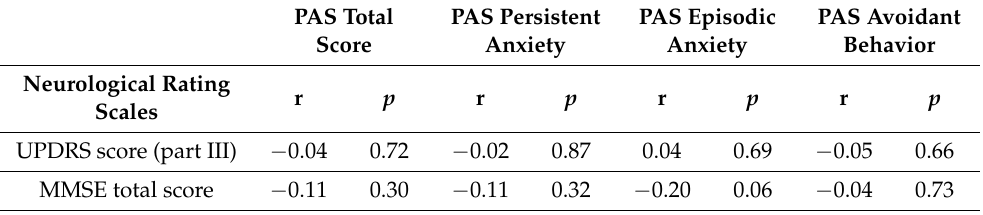
Table 4. Clinical Correlates of Anxiety Symptoms Measured by Parkinson Anxiety Scale